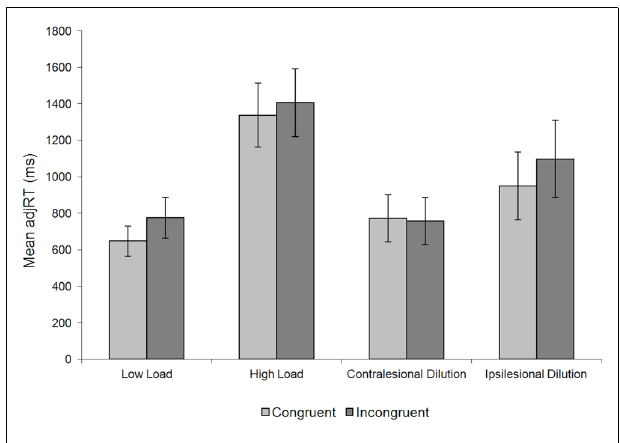
FIGURE 2 | Mean adjRT ( ± SEM) of patients’ performance in the load/dilution